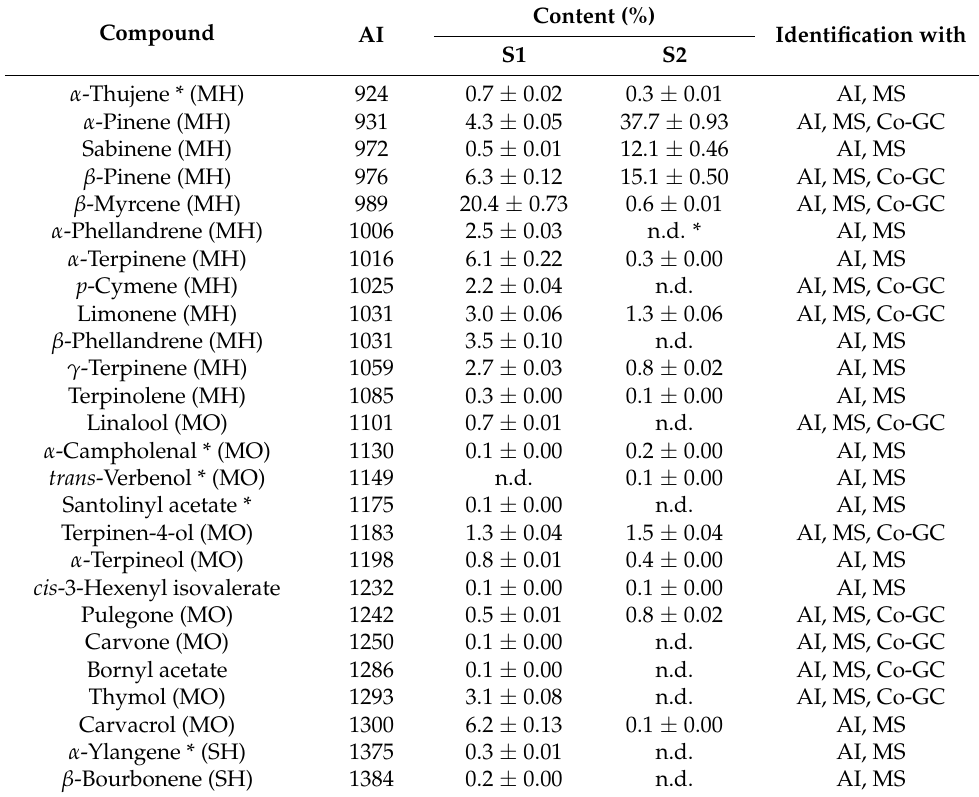
Table 1. Chemical profile of Sideritis sipylea essential oil from wild-growing populations of Mt Kerkis, Samos Island (S1: collected at the peak of flowering) and Mt Olympus in Lesvos Island (S2: collected at the beginning of flowering), Greece (MH: monoterpene hydrocarbons, MO: oxygenated monoterpenes, SH: sesquiterpene hydrocarbons, SO: oxygenated sesquiterpenes). Content (%) Compound AI Identification with